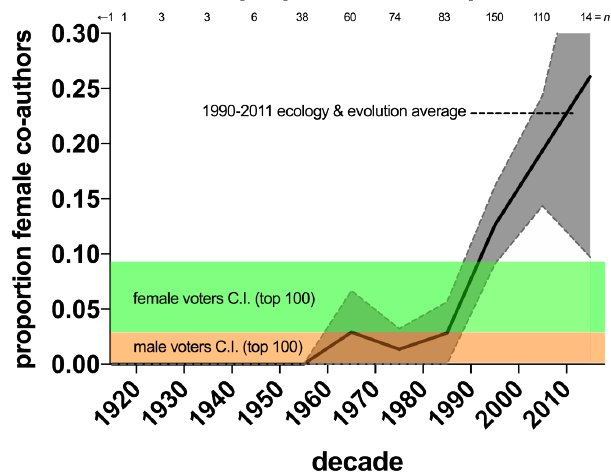
Figure 2. Time series of mean (± 2 standard errors of the mean; grey dashed lines) decadal gender ratio (proportion female co-authors) for all 544 proposed articles. Numbers above the graph indicate sample size (number of articles) used to calculate decadal means (‘ ← 1’ indicates one article from 1858) (Darwin and Wallace 1858). For comparison, the proportion of female authorships in articles published from 1990–2011 in ecology and evolution (22.76% of 279012 total authorships; lower black horizontal dashed line) (West et al. 2013) are shown. Also shown are the 95% confidence limits of the proportion of female co-authors of the 100 top-ranked articles assessed by female (green shaded area: 0.029 to 0.093; Fig. 1b) and male voters (orange-shaded area: 0.001 to 0.029; Fig.